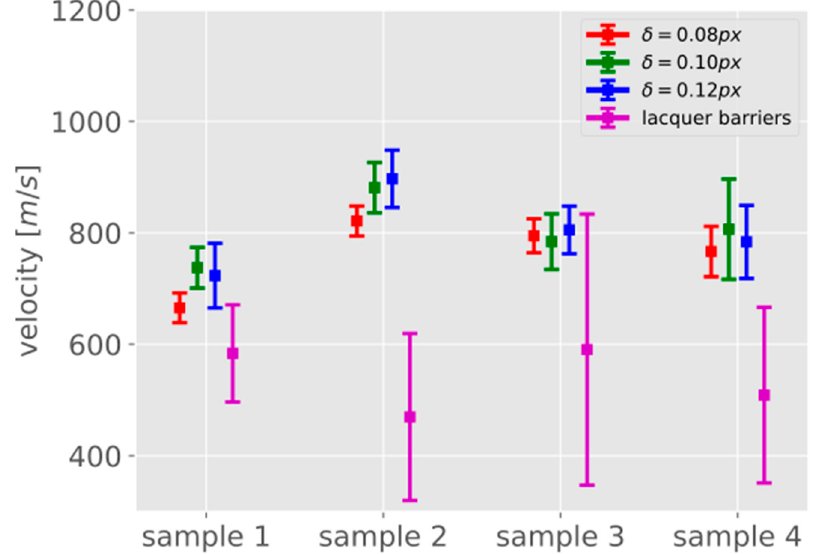
Figure 15. Least-squares velocities obtained using all data points as average velocities and the corresponding standard deviations (error bars: ± one standard deviation) for all specimens.